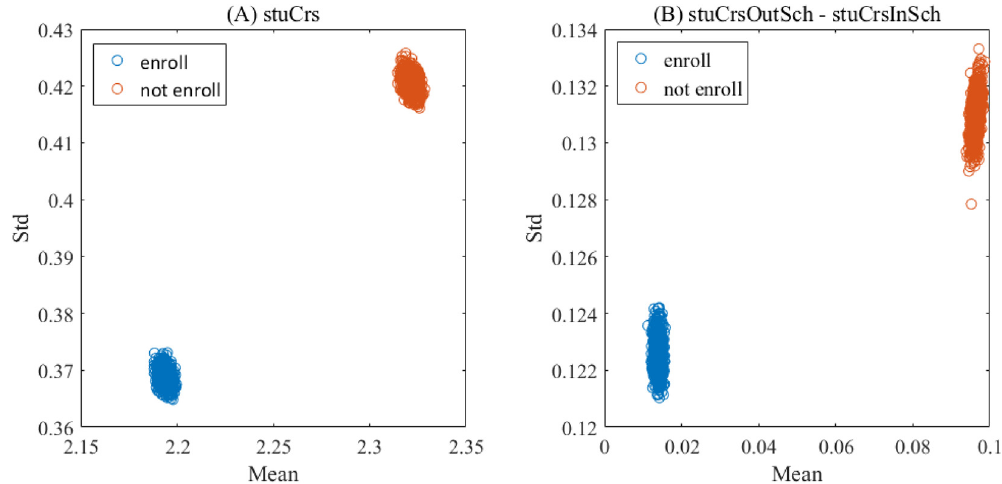
Fig 10. Value distributions of featuresin the course preference. (A) stuCrs. (B) stuCrsOutSch-stuCrsInSch.